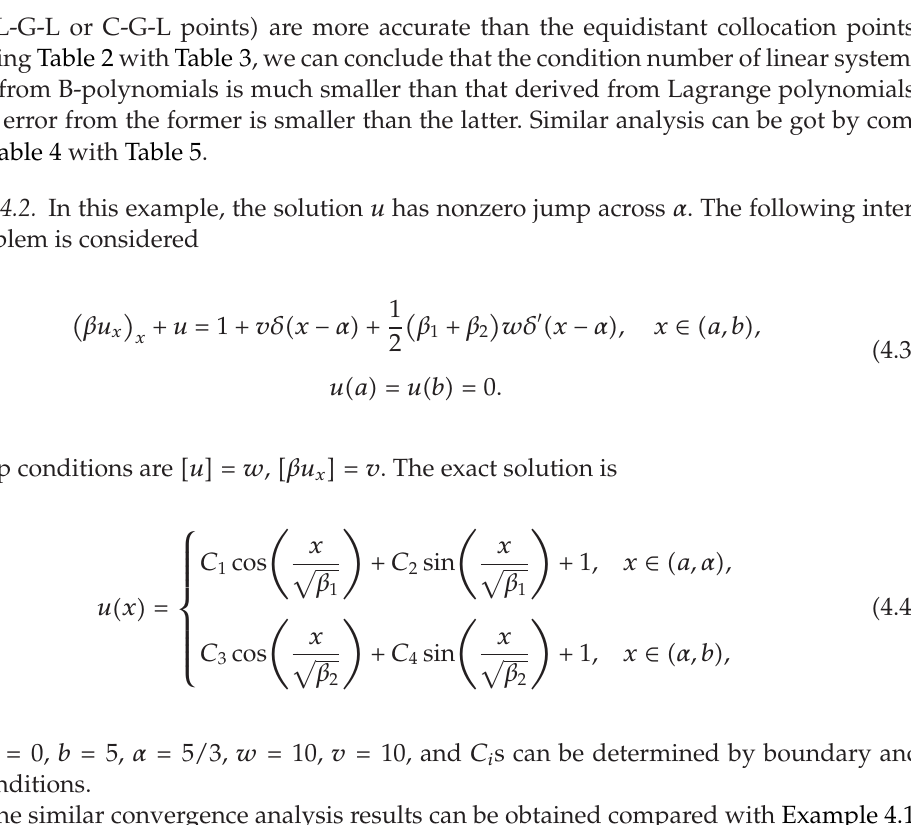
Table 2: Convergence analysis of Example 4.1 by Bernstein collocation method (cid:5) β